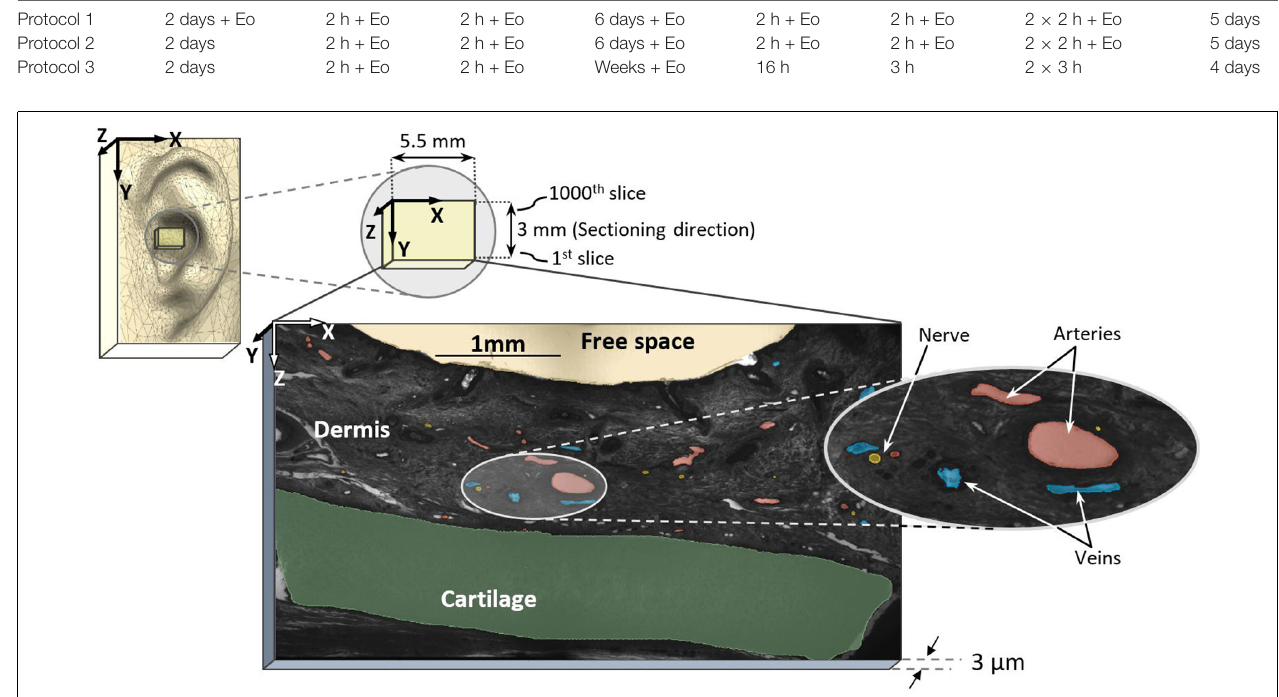
TABLE 2 | Protocols for sample processing to prepare for HREM data generation. Washing Infiltration